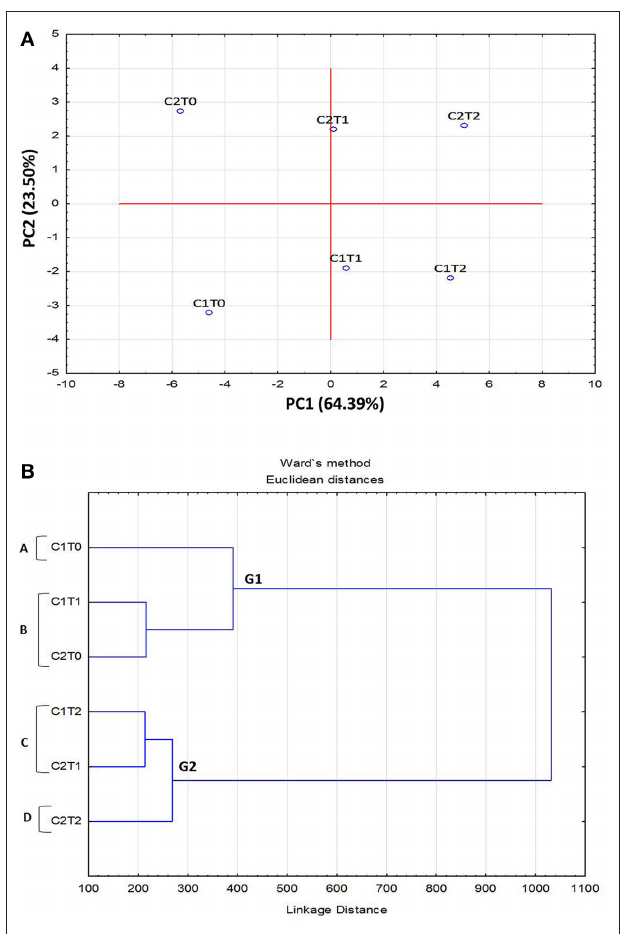
FIGURE 1 | Principal component analysis (PCA) (A) and dendrogram (B) of morphological, physiological, and biochemical attributes in leaves of guava cultivars under drought stress.